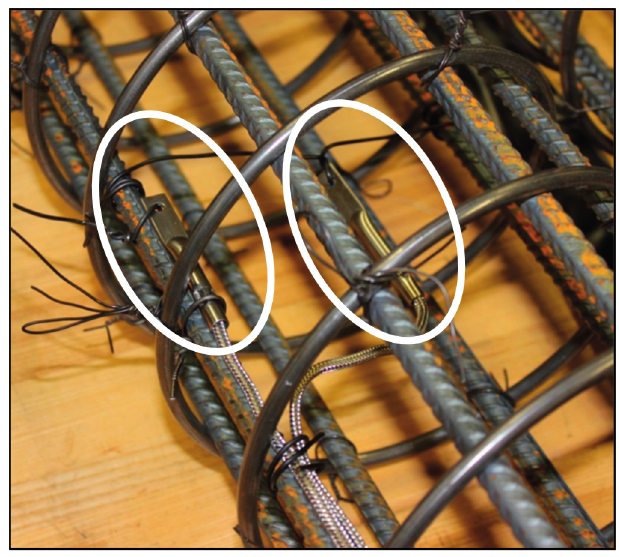
Figure 7. Thermocouples installed within each column